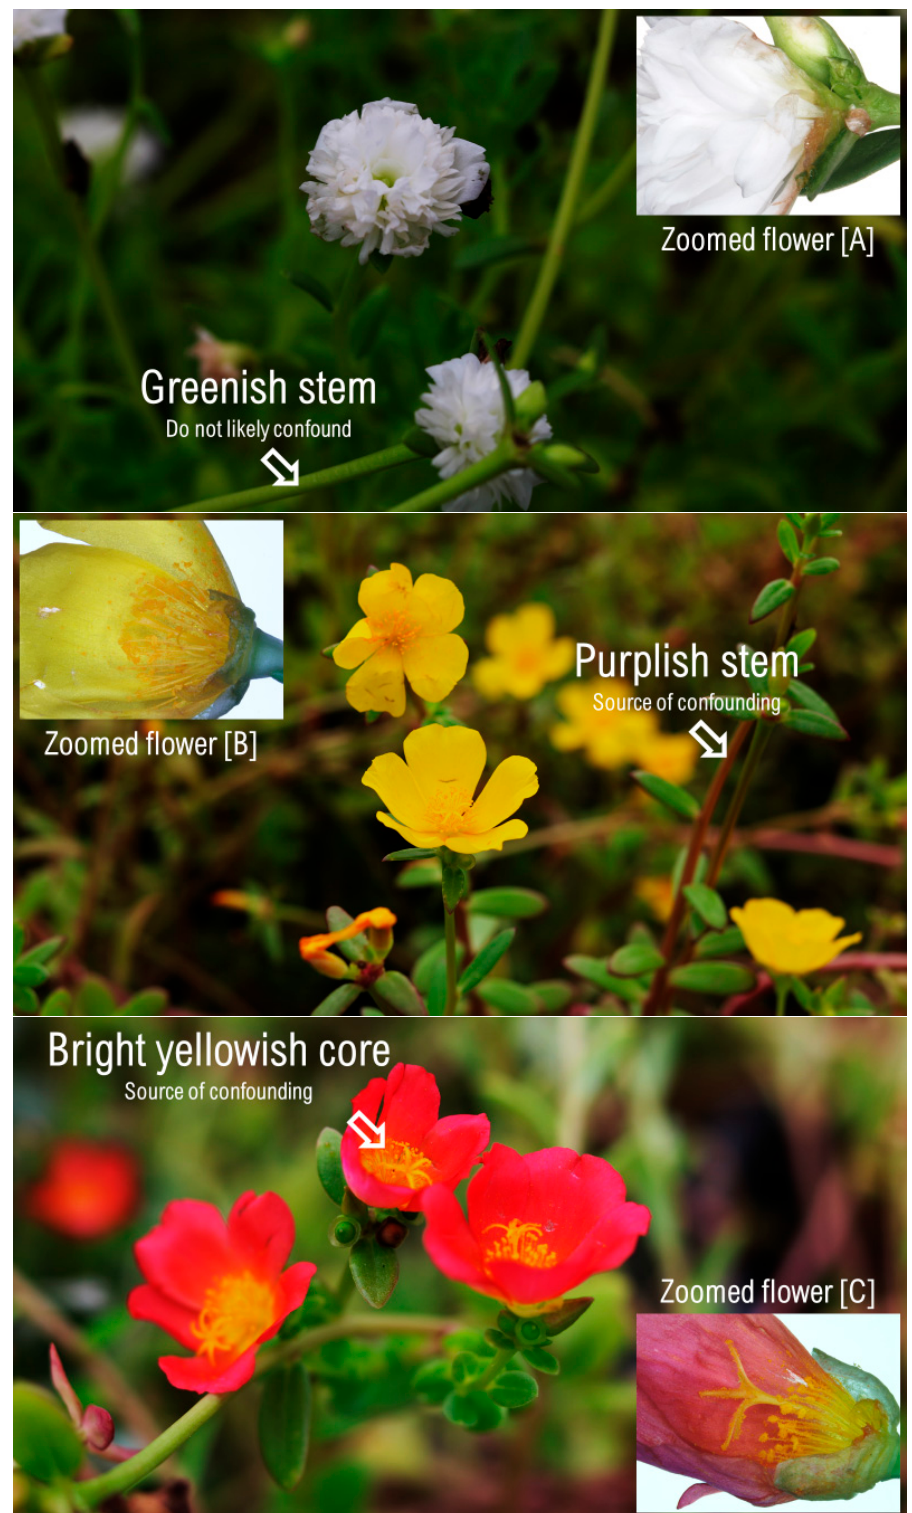
Figure 2. High-resolution digital representation of the anatomy of flowers and architecture of white-flower ( A ), yellow-flower ( B ), and red-flower ( C ) varieties of P. umbraticola . Arrows in the diagram visually assign the sources of confounding (non-random variability or unrealistic structural output-to-input dependency) to the processing of images.